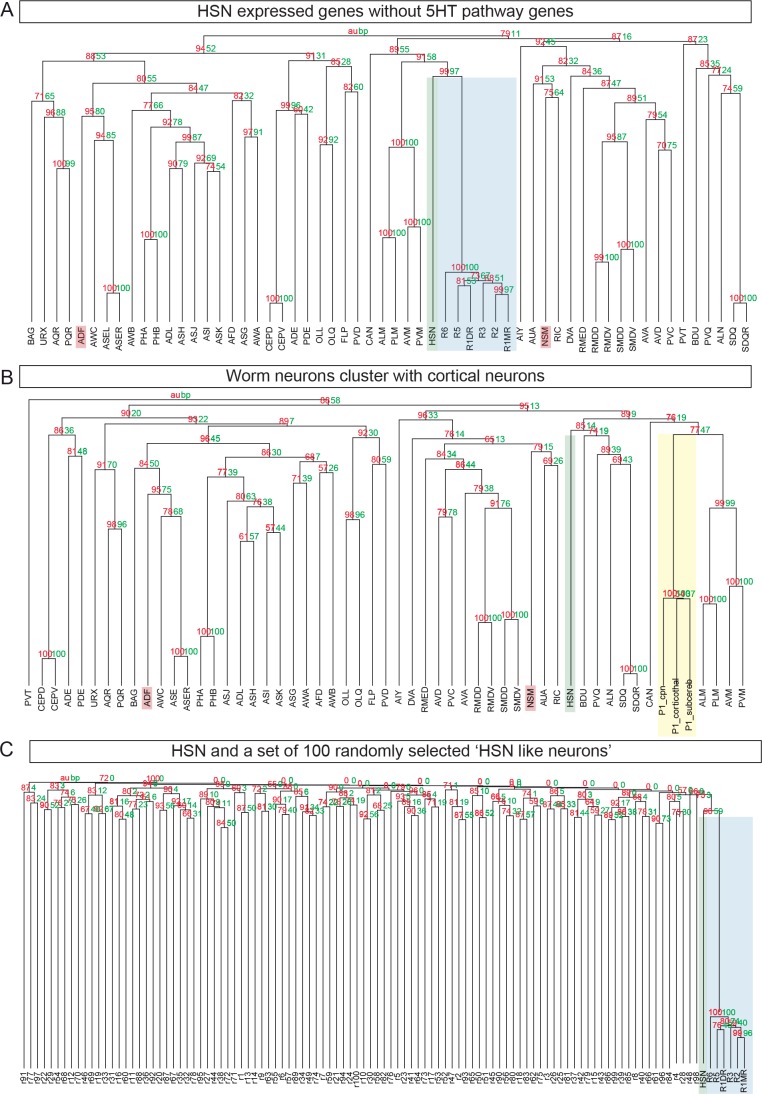
HSN neuron is the C. elegans neuron molecularly closest to mouse raphe serotonergic neurons.(A) pvclust was performed after removing 5HT pathway genes (cat-1, tph-1, bas-1 and cat-4) from the HSN to show that proximity between HSN and mouse raphe is not only due to 5HT pathway genes. (B) Clustering of worm neurons and mouse non-serotonergic control regions [cortical neurons from (Molyneaux et al., 2015) show that HSN expression data cluster with raphe transcriptome is specific as it does not occur with other mouse transcriptomic data. P1_cpn: Postnatal day 1 cortical projection neurons; P1_corticothal: Postnatal day 1 cortical thalamic neurons; P1_subcereb: Postnatal day 1 cortical subcerebral neurons. (C) 100 simulated 'HSN-like' neurons were obtained by assigning to each one the four 5HT pathway genes (cat-1, tph-1, bas-1 and cat-4) and 92 additional genes at random. None of these random profiles shows close proximity to the Raphe mouse neurons.